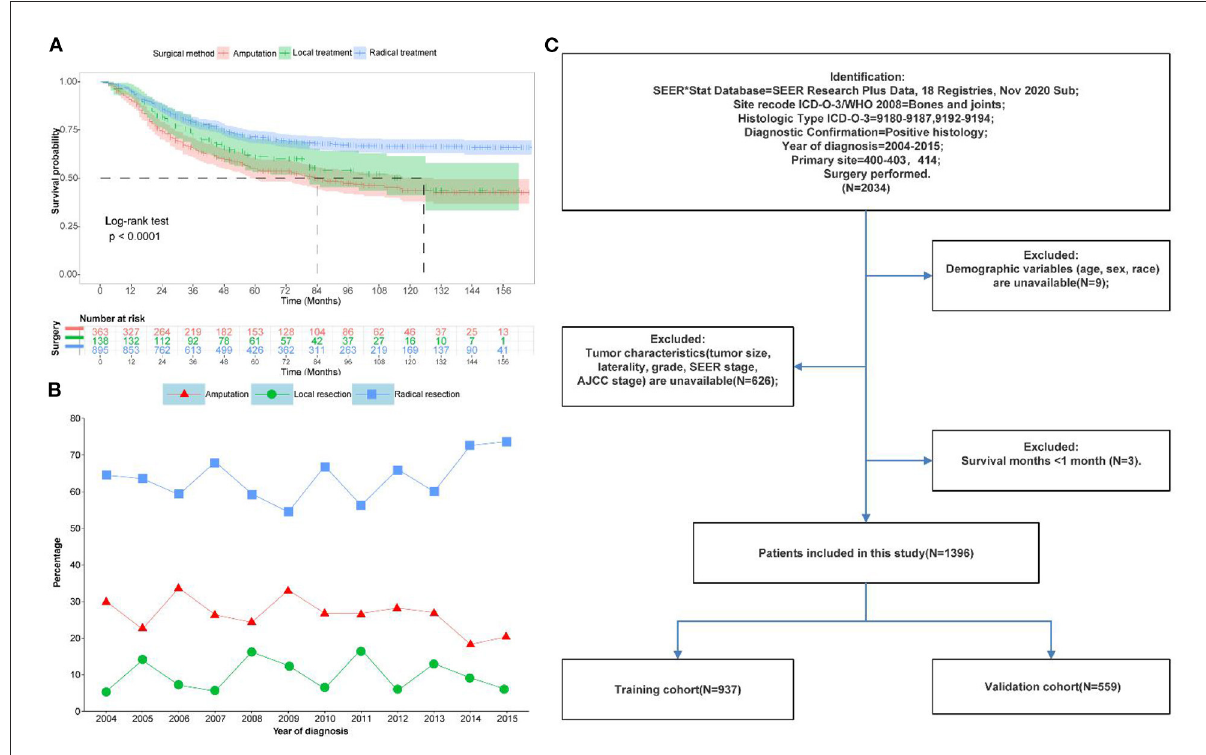
FIGURE1 Data of patients with primary osteosarcoma after surgical resection in this study. (A) Kaplan-Meier survival curves for different surgical options. (B) Trends in different surgical options from 2004 to 2015 (C) Flow chart of patient selection.